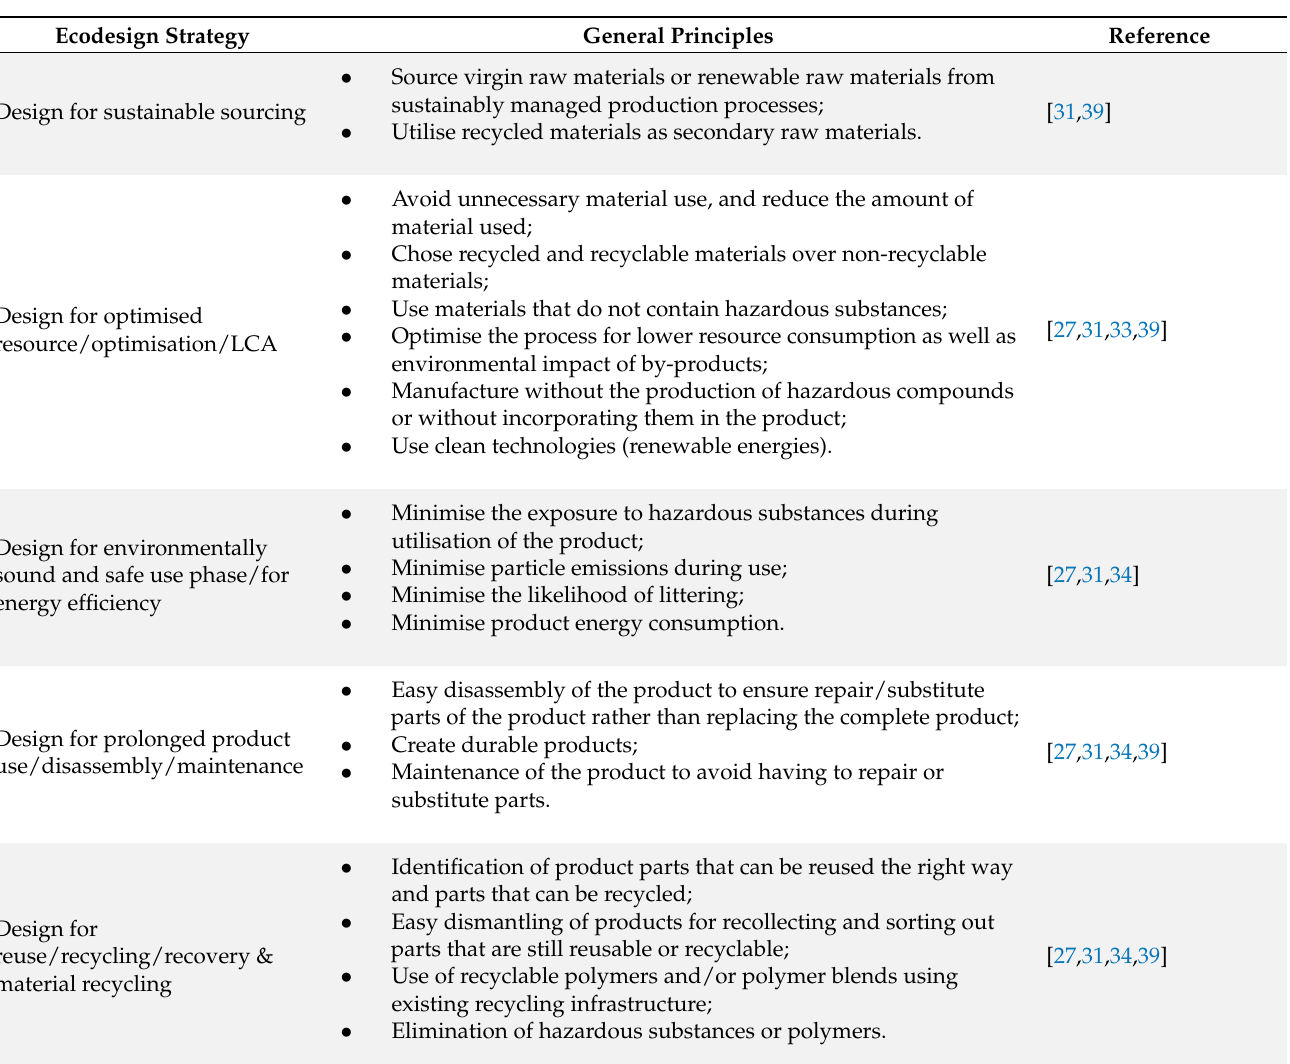
Table 1. Systematisation of different ecodesign strategies meant increasing product and service sustainability. These strategies are collected from different application areas of this concept and are not necessarily related to food design. Various literature sources give various titles to ecodesign goals with the same objectives, making it possible to draw similarities between them and group them. Within the context of food design, “hazardous substances” can be interpreted as “toxic” or “harmful” because, when referring to design for reuse (reprocessing of food products), there may be a generation of toxic substances—e.g., migration of microplastics [37] or other substances [38] from the packaging to the